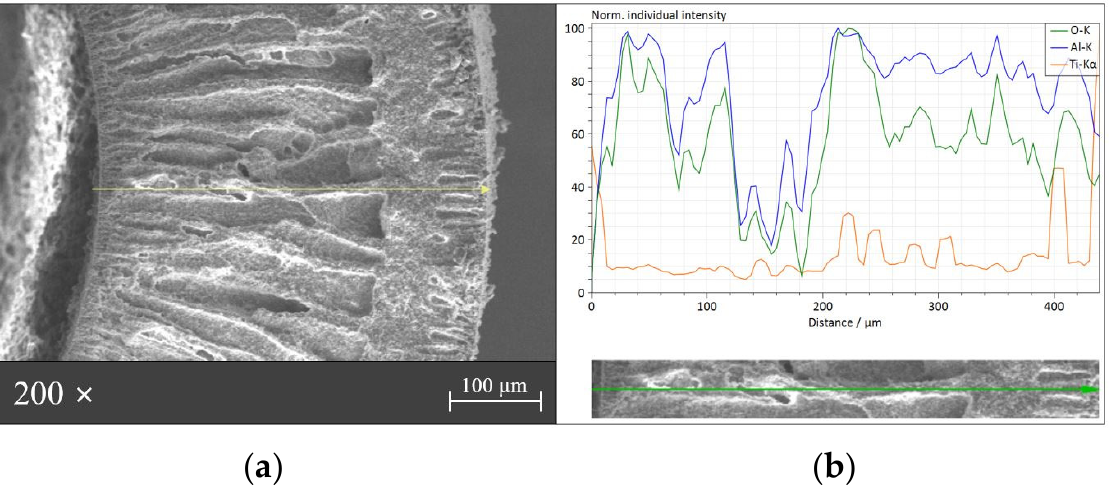
Figure 9. ( a ) SEM image and ( b ) element distribution spectra obtained via EDS line-scanning analysis along the S,N-doped TiO 2 /Al 2 O 3 HF membrane.